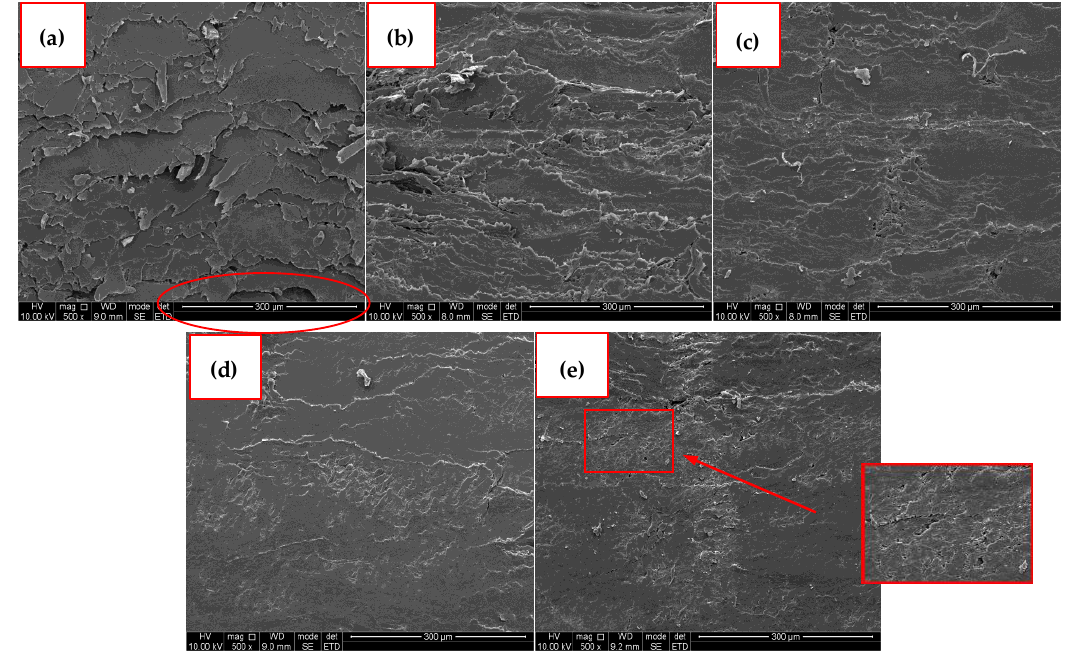
Figure 6. Section morphology of bio-board at different heating temperature (×500). ( a ) 110 °C; ( b ) 140 °C; ( c ) 170 °C; ( d ) 200 °C; ( e ) 230 °C.